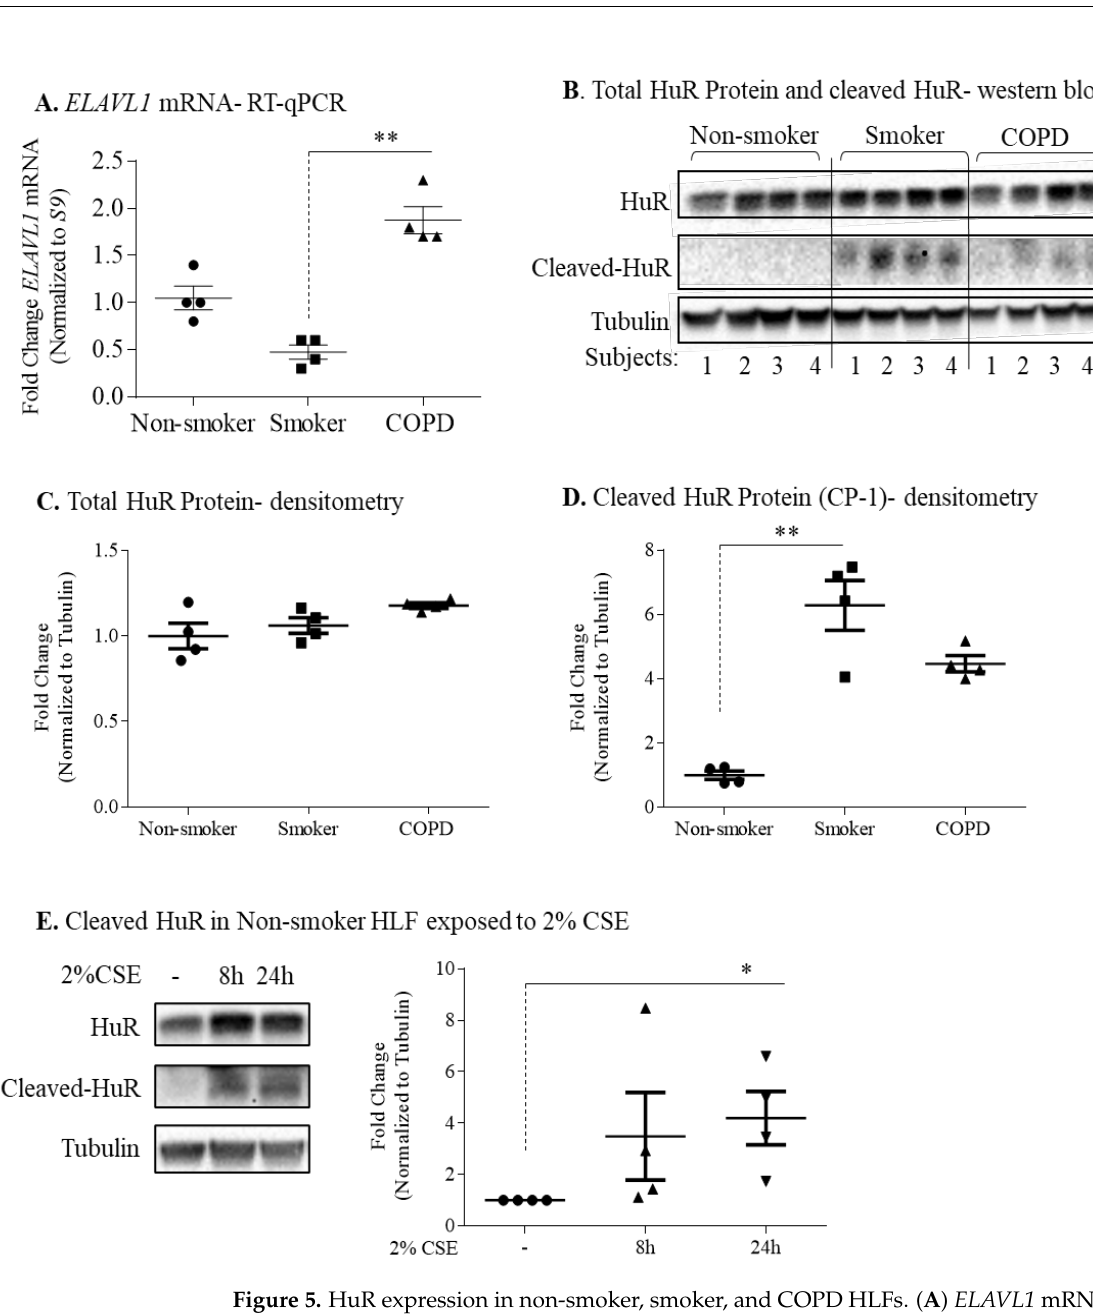
Figure 5. HuR expression in non-smoker, smoker, and COPD HLFs. ( A ) ELAVL1 mRNA-RT-qPCR: HLFs from 4 non-smoker (circle), 4 smoker (square), and 4 COPD (triangle) subjects were harvested for RT-qPCR. There was a significant difference between smoker and COPD-derived HLFs (** p < 0.01). Results are expressed as the mean ± SEM. ( B ) Total HuR Protein—Western blot- densitometry: HLFs from 4 non-smoker, 4 smoker, and 4 COPD subjects were harvested for Western blot. HuR protein expression was detected at the predicted MW of 34 kDa. The cleaved HuR product (CP-1, 27 kDa) was detected in HLFs from smoker and COPD subjects. β -Tubulin was used as loading control. ( C ) Total HuR Protein—densitometry: there was no significant difference in total expression of HuR between non-smoker (circle), smoker (square), and COPD (triangle) HLFs. Results are expressed as the mean ± SEM. ( D ) Cleaved HuR Protein (CP-1)—densitometry: there was significant increase in the cleaved HuR (CP-1) in smoker (square) HLFs comparing to non-smoker (circle) HLFs (** p = 0.009). Results are expressed as the mean ± SEM. ( E ). Cleaved HuR in non-smoker HLFs exposed to 2% CSE: there was an increase in the cleaved HuR product (CP-1) in HLFs from non-smokers exposed to 2% CSE for 8 h and 24 h (* p = 0.01). Results are expressed as the mean ± SEM of 4 independent